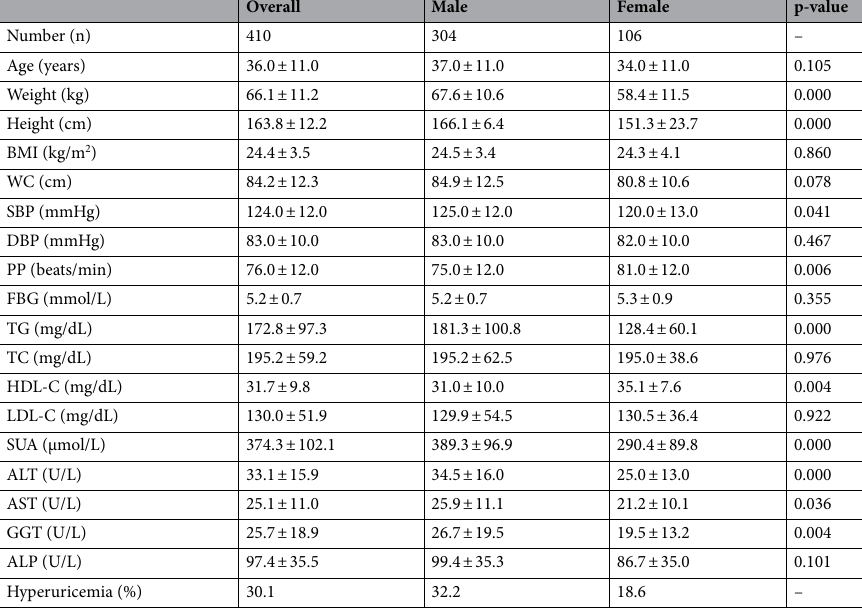
Table 1. Baseline characteristics of the study participants according to sex. Values are presented as mean ± SD. p-values are given for differences between the gender groups, obtained from an independent sample t test.